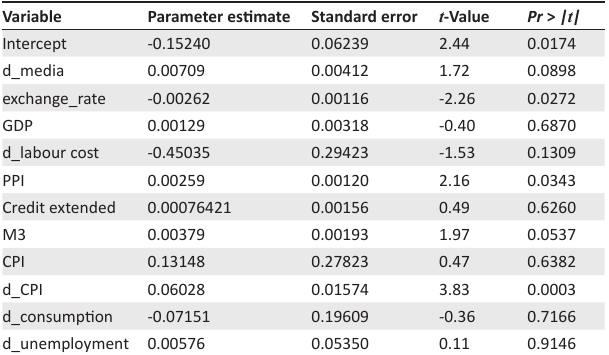
TABLE 2: Model 1: Dependent Variable: interest rates.